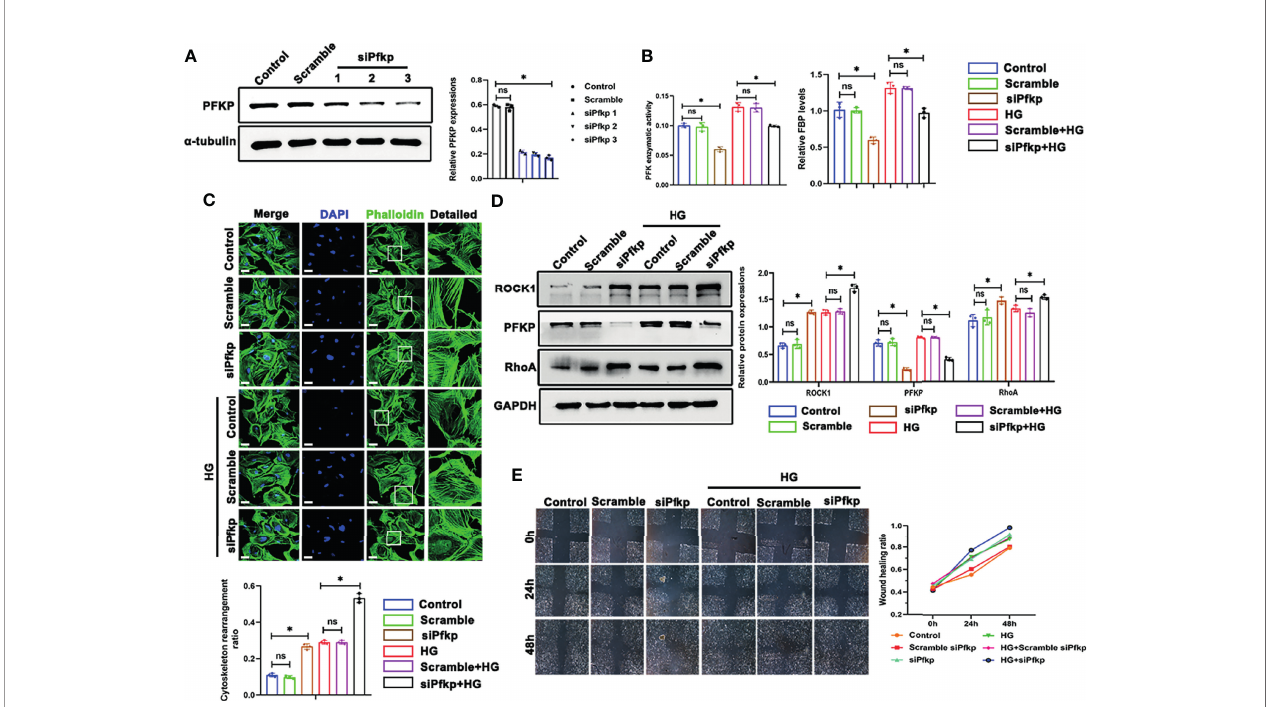
FIGURE 6 | Deletion of PFKP aggravated HG-induced cytoskeletal remodeling in podocytes in vitro . (A) Western blots of PFKP expression after transfection with various siPfkps , with GAPDH set as the loading control. (B) PFK enzymatic activity and FBP level in each group. (C) Cytoskeletal structures of podocytes labeled with phalloidin and the cytoskeletal rearrangement ratio in each group (original magni fi cation ×600). (D) Western blotting analyses of the expression of ROCK1, PFKP, and RhoA in podocytes of each group. GAPDH was set as the loading control. (E) Motility of podocytes measured by a wound-healing assay using an inverted microscope. For all fi gures, n=3 independent experiments/group. * P < 0.05, ns, No signi fi cance. Scale bars: 10 µm. HG, high glucose; ROCK1, Rho- associated, coiled-coil containing protein kinase 1; PFKP, phosphofructokinase 1 platelet type; RhoA,